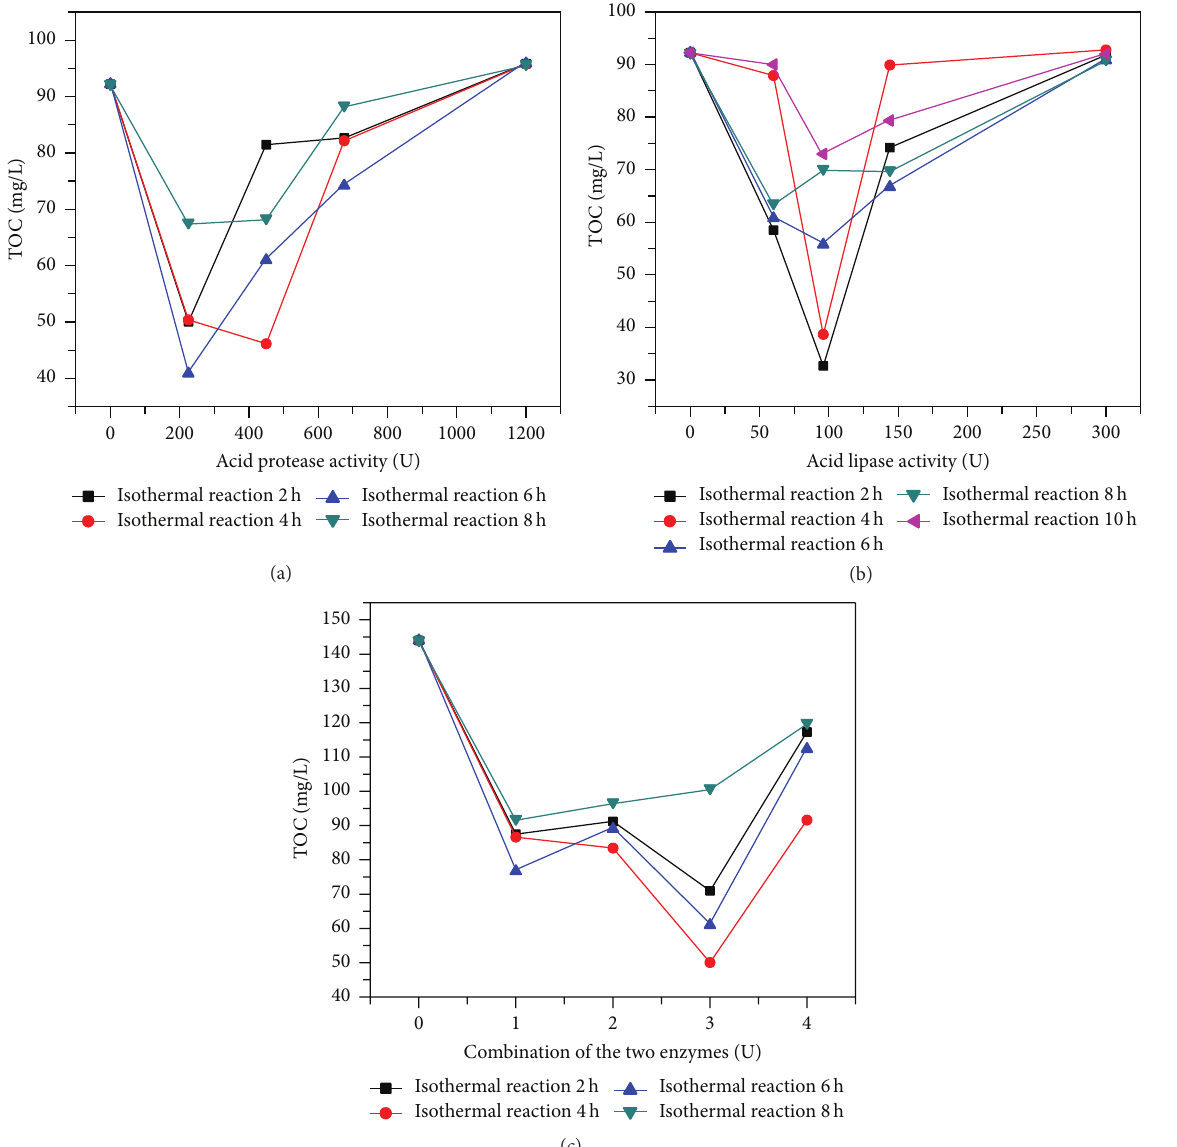
Figure 3: The change of TOC with the amount of acid enzyme activities (the combination of acid protease and lipase represented, resp., in (c): (0) control group, (1) 1.8 and 14.4 U, (2) 2.7 and 21.6U, (3) 3.6 and 28.8 U, and (4) 4.5 and 36 U).